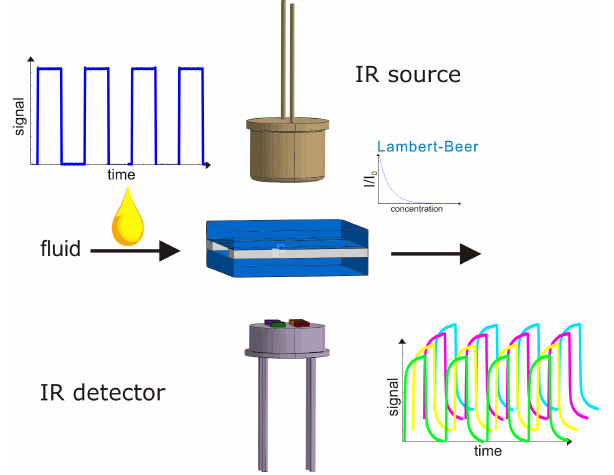
Figure 1. Schematic of the sensor system (Bley et al.,